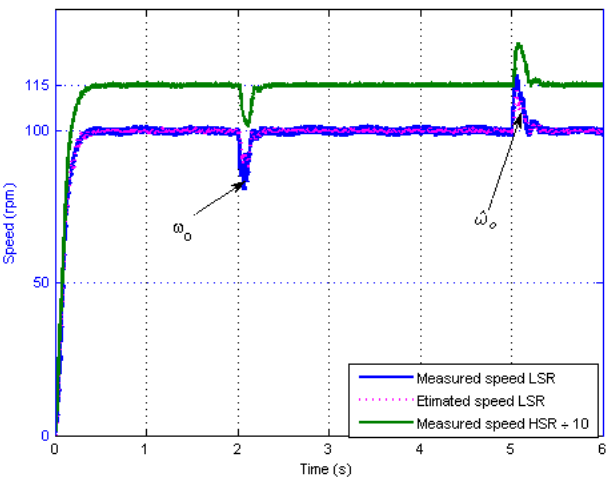
Figure 17. Measured and estimated LSR and HSR speeds.